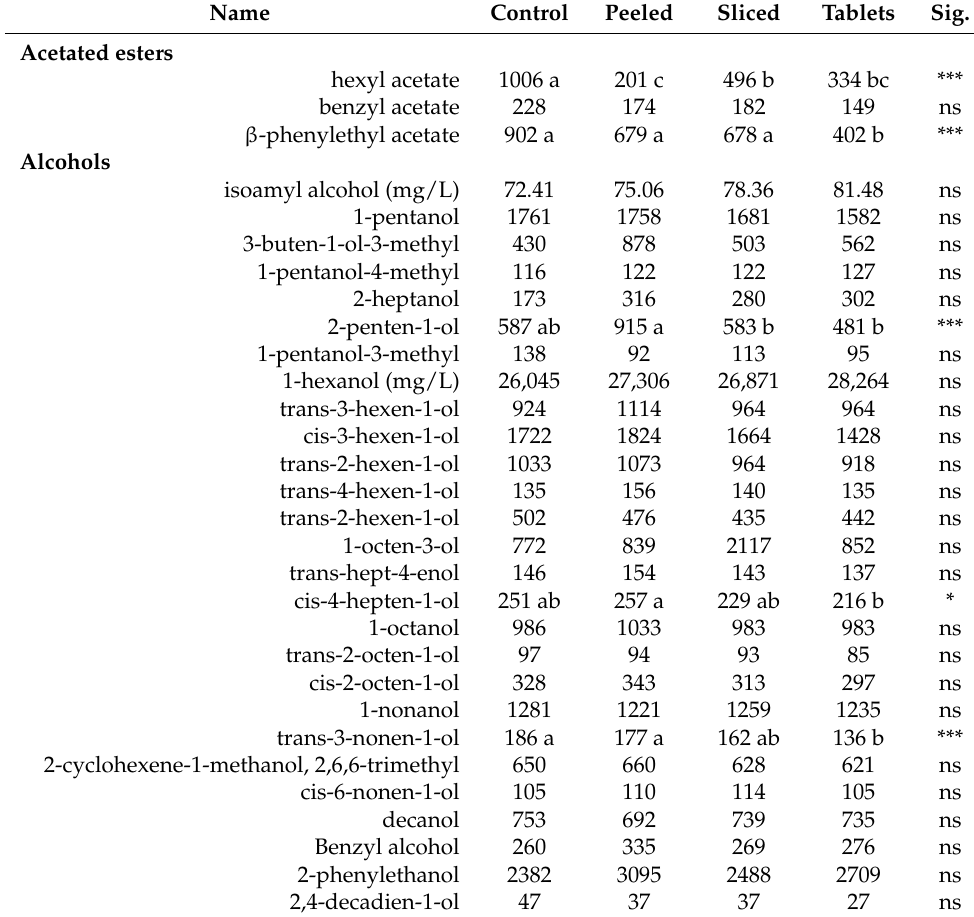
Table 5. Effect of wood format on the general aromatic composition of the distillate. All data are expressed in µ g/L except where expressly indicated. Different letters within each row denote significant difference between the wines at p < 0.05 (Tukey’s post hoc test). *, **, *** and ns: differences significant at p < 0.05, 0.01, 0.001 and not significant, respectively. The main groups of compounds analyzed are highlighted in